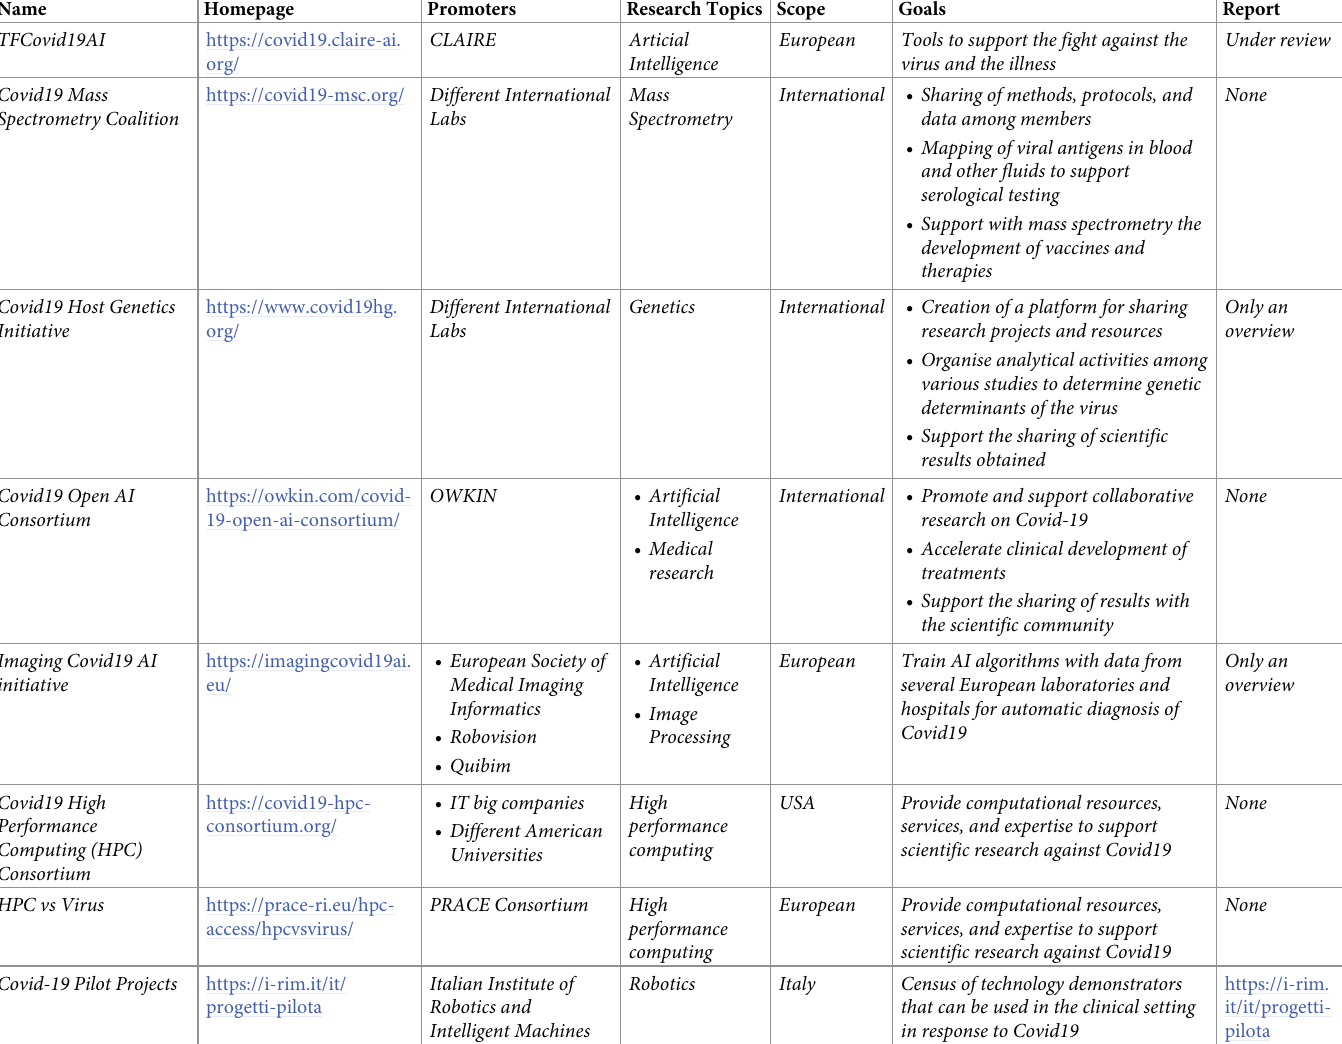
Table 1. Coalitions established to fight